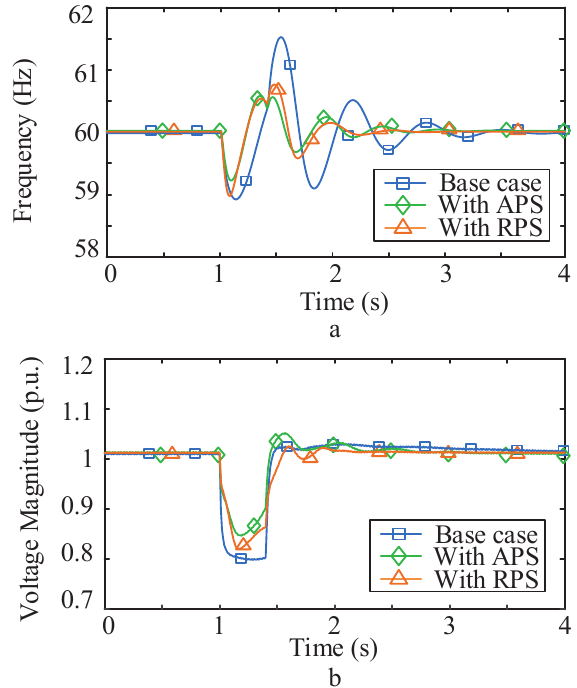
Figure 9. Synchronous DG response to three-phase fault; ( a ) Frequency ( b ) Terminal